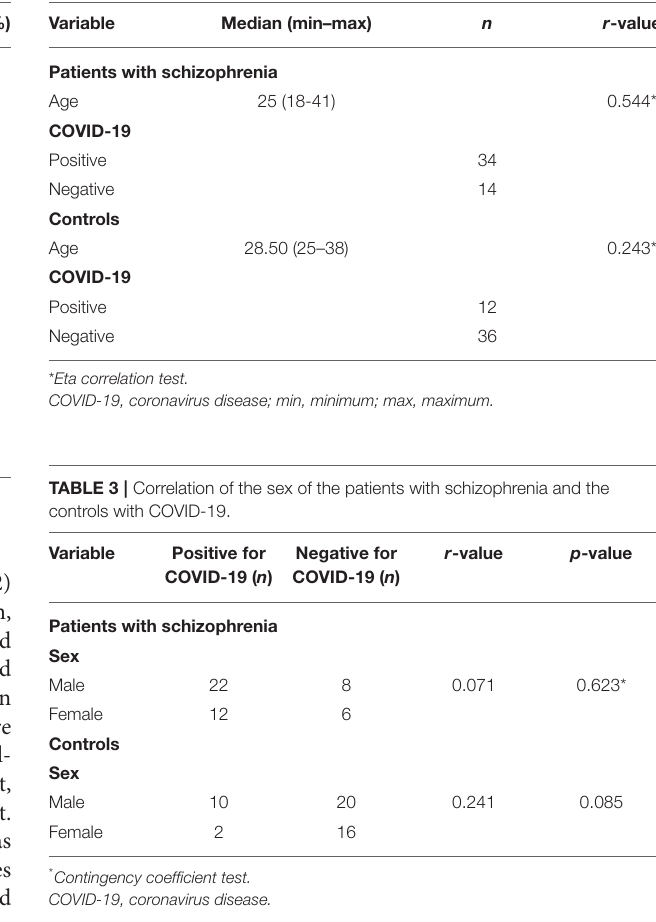
TABLE 2 | Correlation of the age of the patients with schizophrenia and the controls with COVID-19.